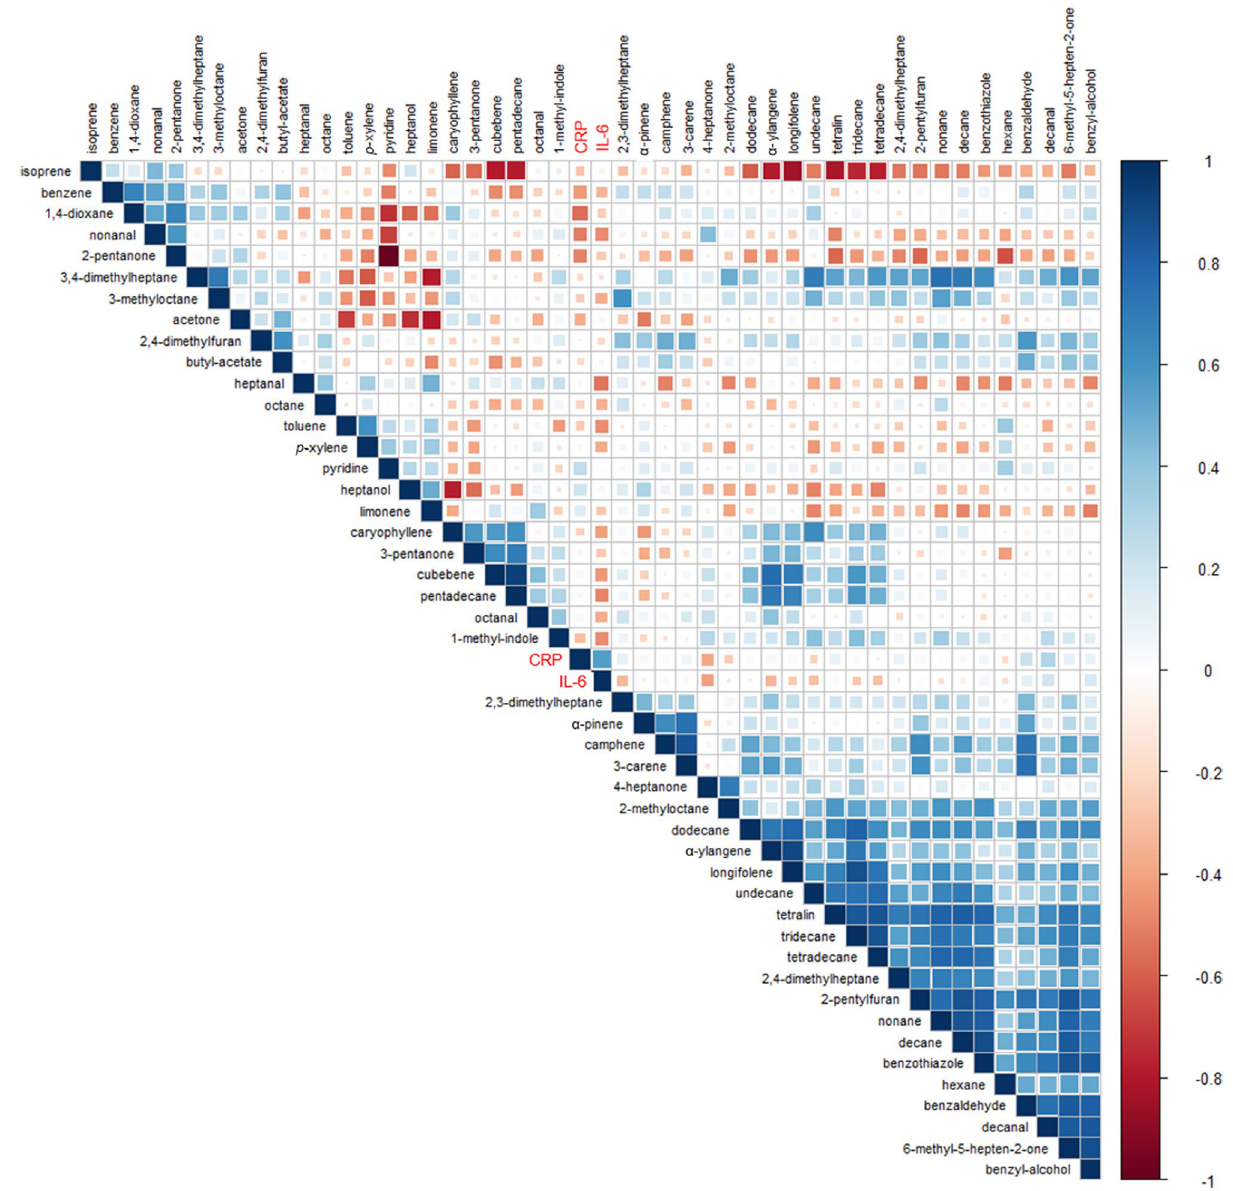
Figure 5. Correlations matrix plot of breath VOCs and inflammatory markers (CRP and IL-6) ordered by hierarchical clustering. Pearson’s correlation coefficients are shown by colour strength and circle size, where 1 is strong positive correlation, -1 is strong negative correlation, and 0 is no